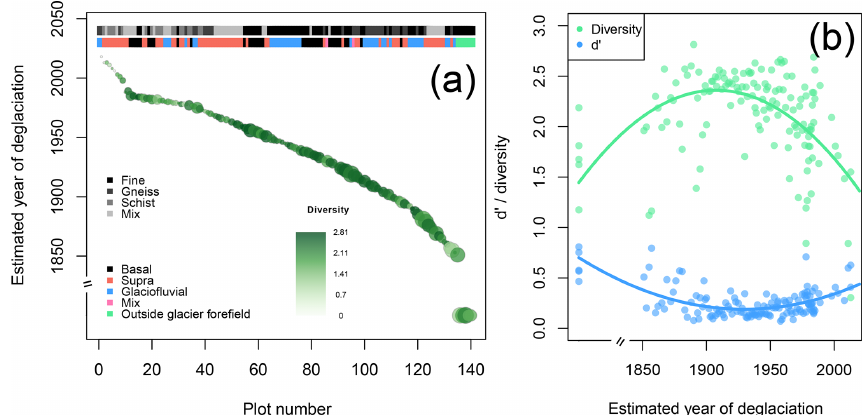
Figure 3. Diversity and plant cover at the n = 140 study plots. (a) The estimated year of deglaciation decreases with plot number. For each plot the plant cover (circle size) and diversity (circle color) are given. The upper bar on the top of the panel informs about the lithological category of each plot, the lower bar about the geomorphological process responsible for the deposition of material on the plots. Plot age increases with plot number. (b) Plant Shannon diversity (green) and d (cid:48) (blue) as a function of plot age (old plots are on the right, young plots on the left). d (cid:48) informs about the degree of uniqueness of each plot regarding the composition of plant species. Low d (cid:48) values indicate that plots share all or most plant species with many other plots; high d (cid:48) values indicate that plots are vegetated with plant species that are unique or shared with few plots